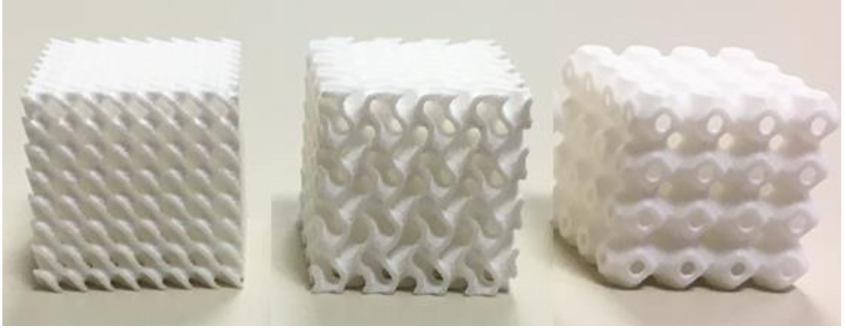
Figure 1. 3D printed sca ff olds: Schwartz D (SD70), Gyroid (SG70), and Schwartz P (SP70) (from left to